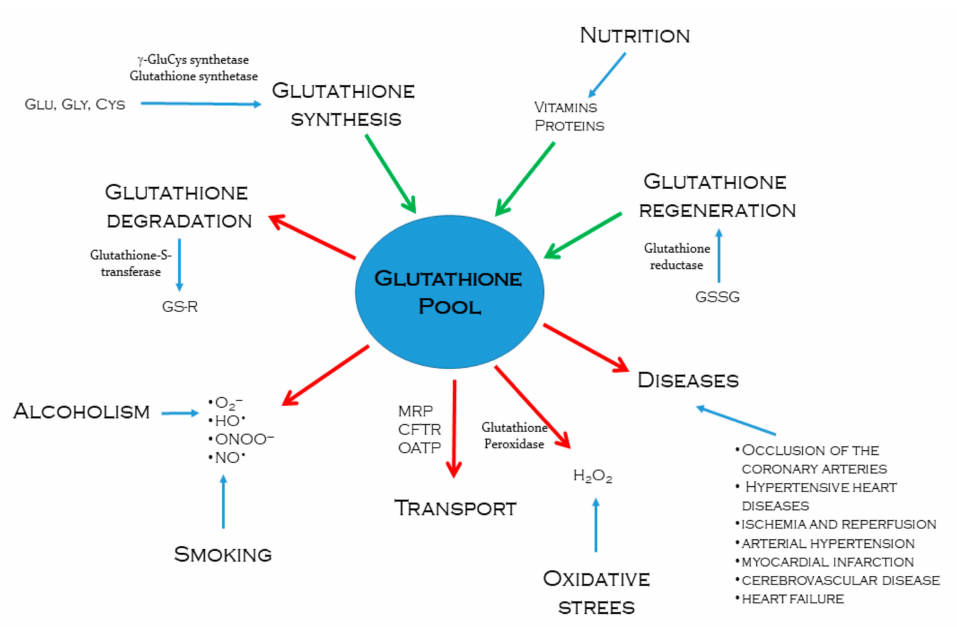
Figure 1. Processes that regulate intracellular glutathione pool. Green arrows indicate glutathione synthesis or regeneration through different metabolic pathways. Enzymes such as γ -glutamylcysteine synthetase, glutathione synthetase, and glutathione reductase are actively involved. The red arrows indicate the ways in which glutathione is used to neutralize and eliminate drugs or toxic metabolites to the body, facing oxidative stress caused by alcoholism and smoking. Intracellular glutathione also decreases as it is transported from the tissues that synthesize it in significant quantities to tissues that require greater antioxidant